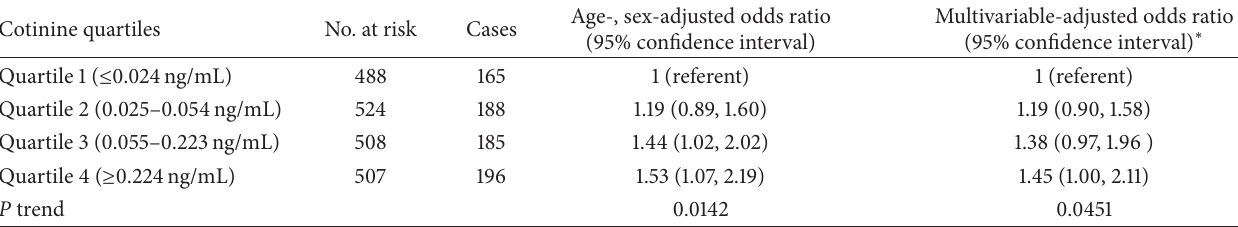
Table 2: Association between serum cotinine levels and prehypertension.